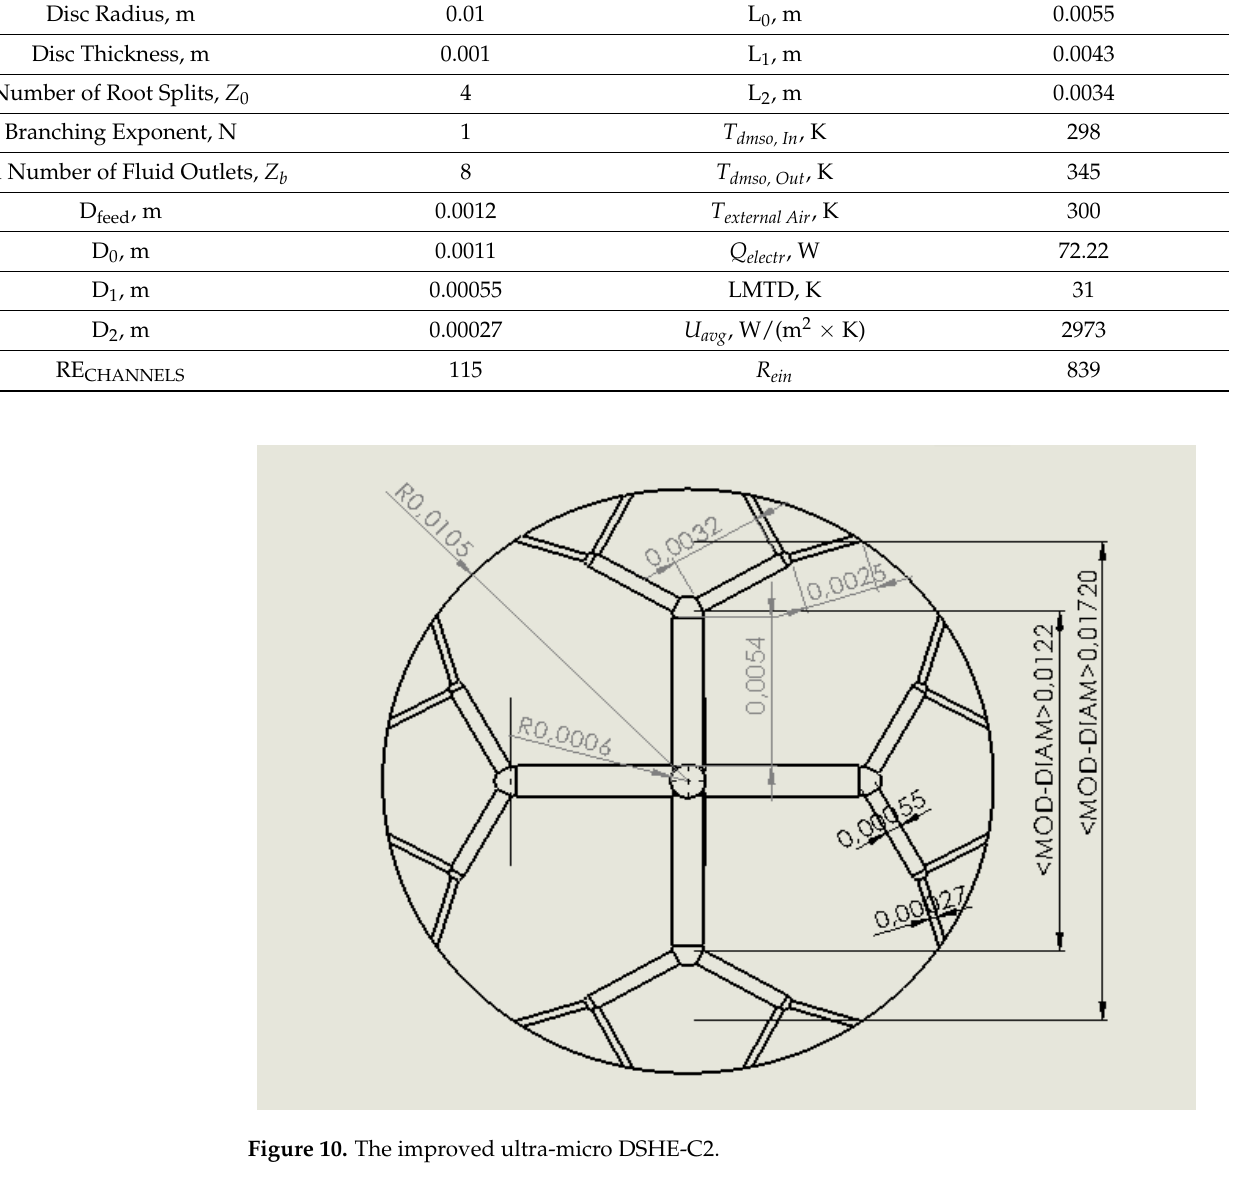
Figure 11. Two 3 – D renderings of the improved DSHE-C2. 6. Conclusions A simple procedure for the design of a disc-shaped heat exchanger with internal bi- furcated cooling channels is presented and discussed. The goal of this exercise is to show that, while the study of the onset and operation of bifurcated structures in nature requires accurate considerations of optimal energy (exergy) use ratios [5,13 – 15], when it comes to engineered devices it is not always necessary to “mimic Nature ”, as many authors (in- cluding the present one!) have repeatedly stated. As mentioned in the Introduction, it is necessary to consider the “Interpretation of Nature” and the “Design of a branched heat exchanger ” as two quite different activities: the former is a reverse design problem, while the second is obvi ously a direct one. “ I nterpreting Nature” involves several highly con- ceptual steps: first, one must recognize that “similar shapes” exist in natural structures (branching of waterways, of tree twigs, of capillaries in biological tissues, etc.) that are